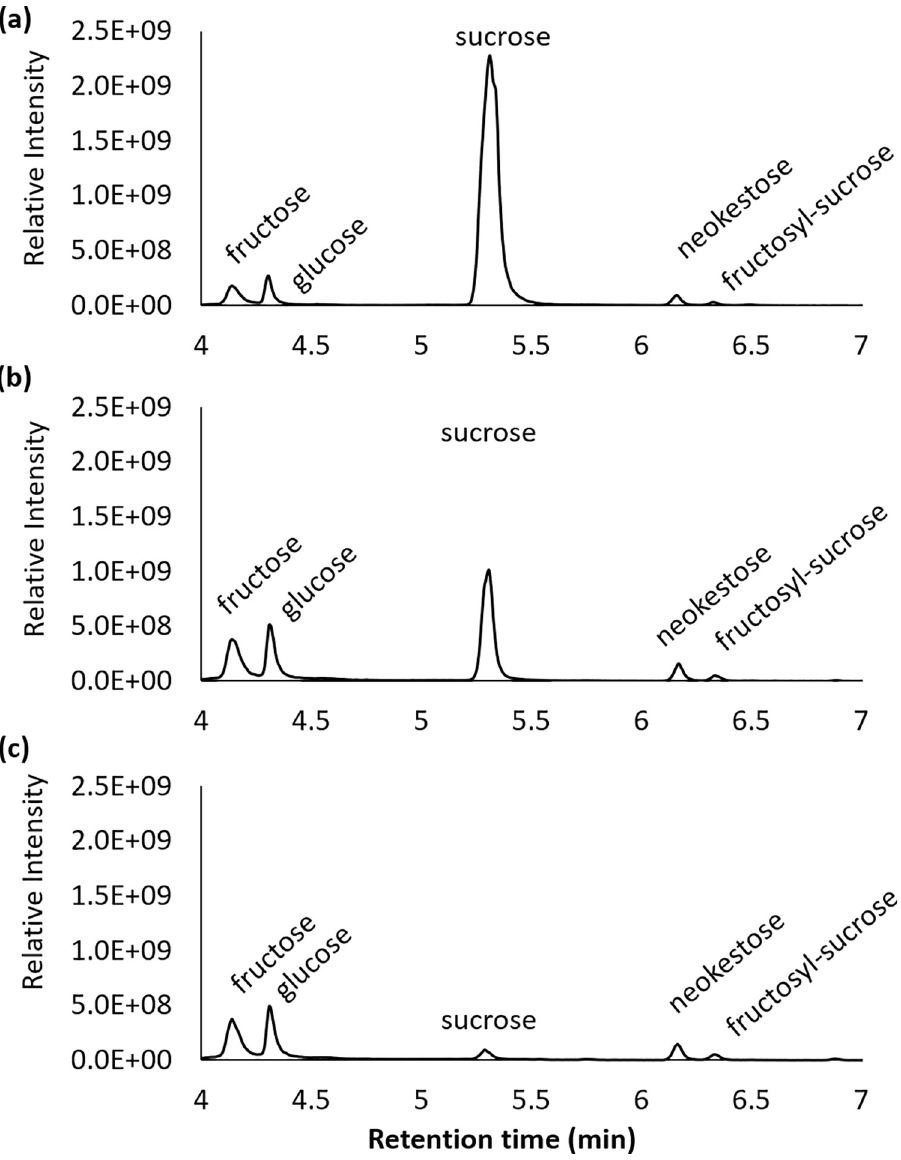
Fig 5. Extracted ion chromatograms of HILIC analyzed fructose, glucose, sucrose, neokestose, and fructosyl- sucrose, all detected as the [M-HCO2-] adduct in negative ionization mode. (a) In early season sap DTBB 50–60, sucrose was the major saccharide detected, decreased after (b) DTBB 30, and was present at low concentrations after (c) DTBB 20.